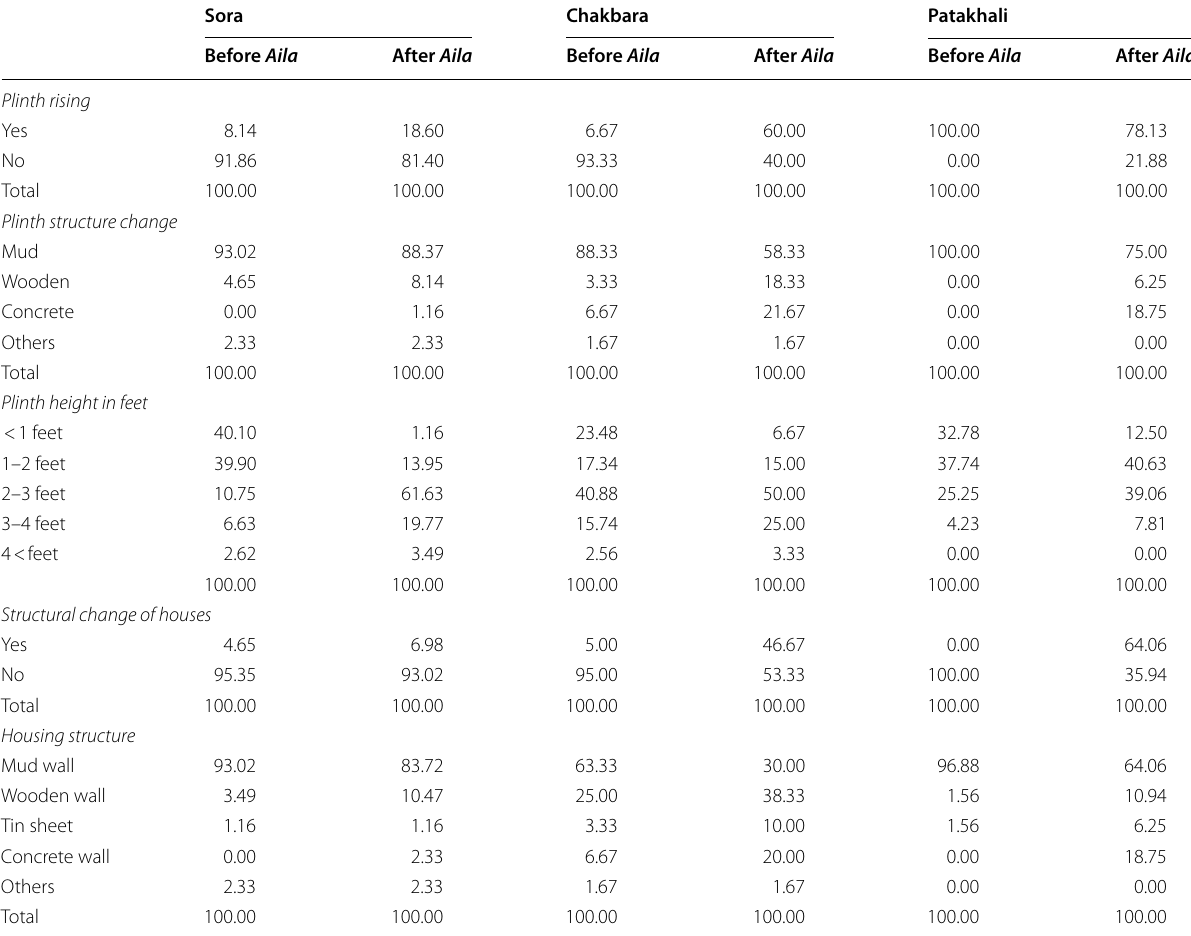
Table 3 Change in housing structures and materials to adapt with the situation (in